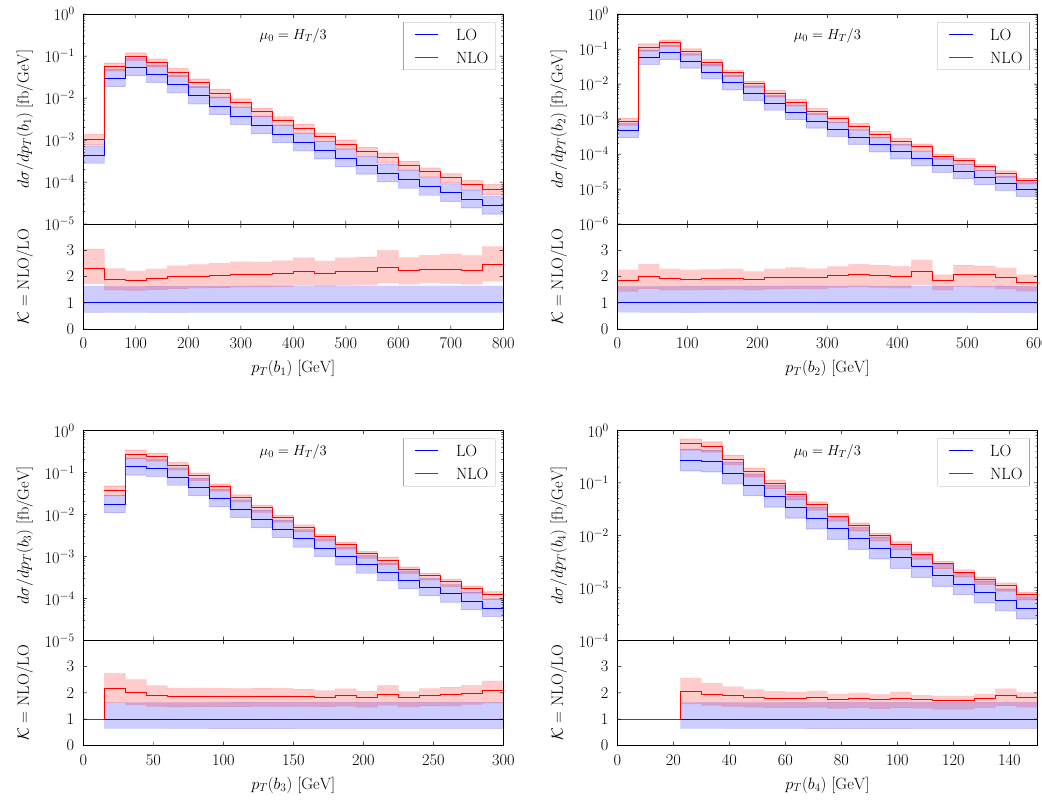
Figure 5 . Differential cross section distributions as a function of the transverse momentum of the 1 st , 2 nd , 3 rd and the 4 th hardest b -jet at LO and NLO for the pp → e + ν e µ − ¯ ν µ b ¯ b b ¯ b + X process √ at the LHC with s = 13 TeV. The heavy-flavour jets are ordered in p T . The upper plots show absolute LO and NLO QCD predictions together with corresponding uncertainty bands. The lower panels display the differential K -factor together with the uncertainty band and the relative scale uncertainties of the LO cross section. Results are provided for µ R = µ F = µ 0 = H T / 3 . The LO and the NLO NNPDF3.1 PDF sets are